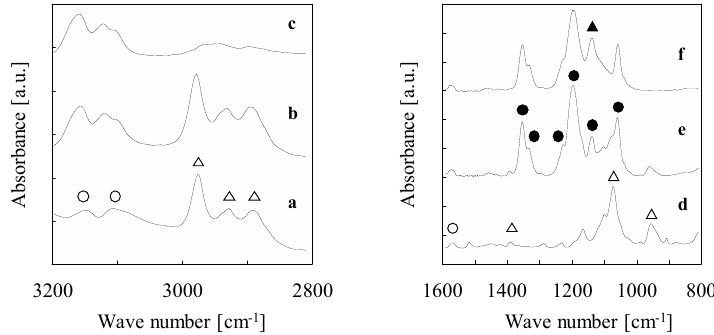
Figure 2. ATR-IR spectra of ( a , d ) SipmimCl; ( b , e ) SipmimTf 2 N; and ( c , f ) polycondensed-SipmimTf 2 N. ( ○ Imidazolium cation, △ -OC 2 H 5 group, ● Tf 2 N anion, ▲ Si-O-Si).